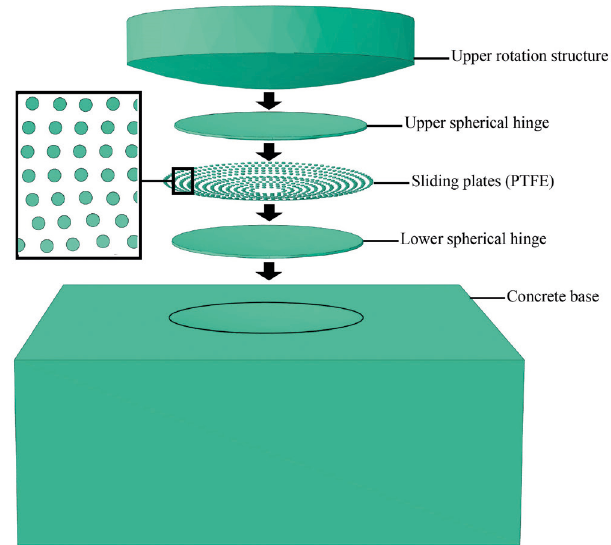
Figure 5. Illustration of the rotating mechanical components in the Finite Element